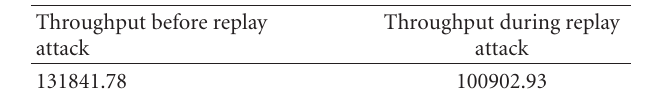
Figure 13: Exposing Gmail account information by the MITM attack. Table 3: Impact of data replay attack on throughput of wireless network (Bps).